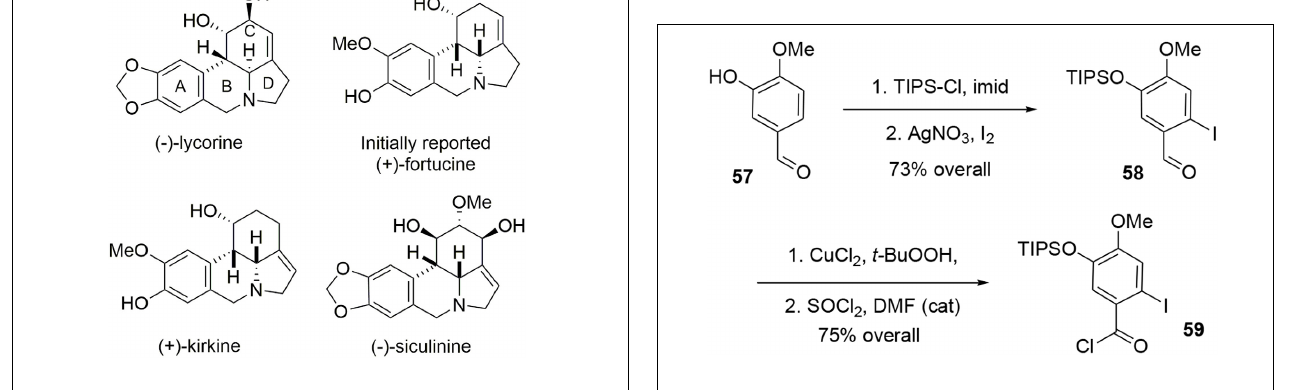
FIGURE 11 | Lycorine alkaloids.